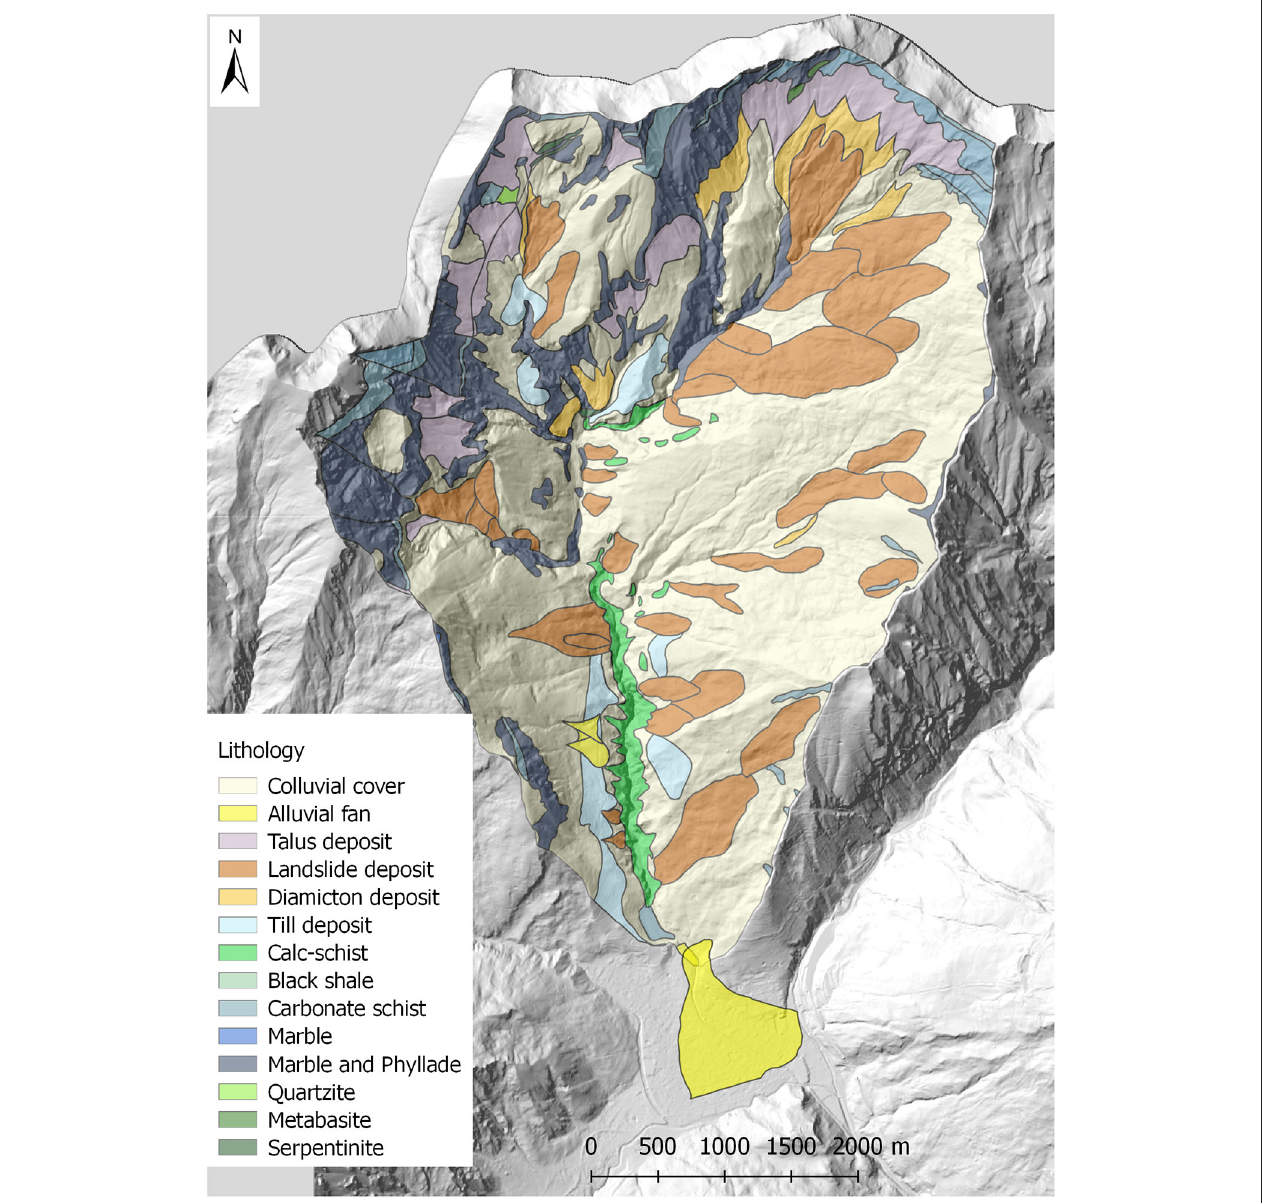
FIGURE 2 | The geological sketch map of Rio Frejus